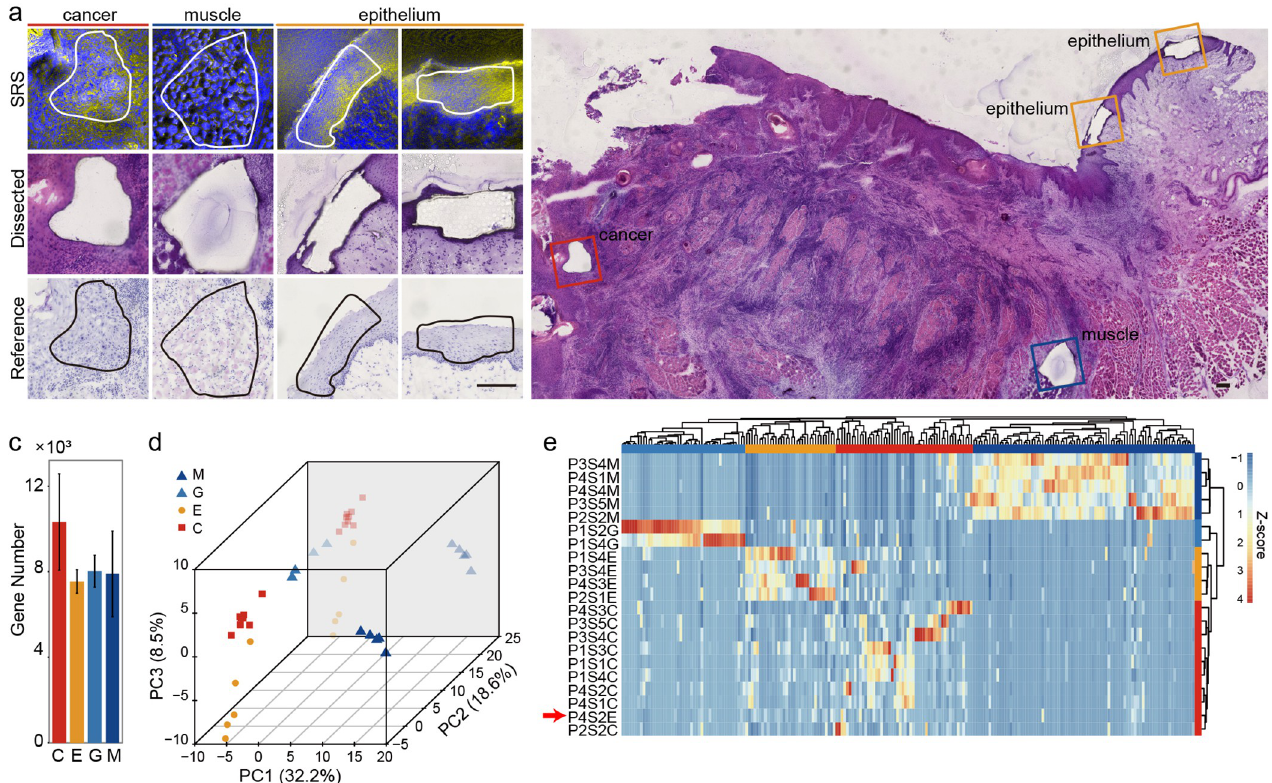
Fig 2. SRS image guided microdissection and evaluation of mRNA recovery. (a) Comparison between SRS images, HE-stained and unstained microtissue section. (b) Epithelium, muscle, and cancer from the same section. (c) Statistics of gene number per sample. (d) PCA plot of all expressed genes. (e) Unsupervised clustering of 217 differently expressed genes from microdissected samples. Scale bars are 200 μ m. Source data for panels c–e in S2 Data Sheet 2.1–2.3. HE, hematoxylin–eosin; PCA, principal component analysis; SRS, stimulated Raman scattering.